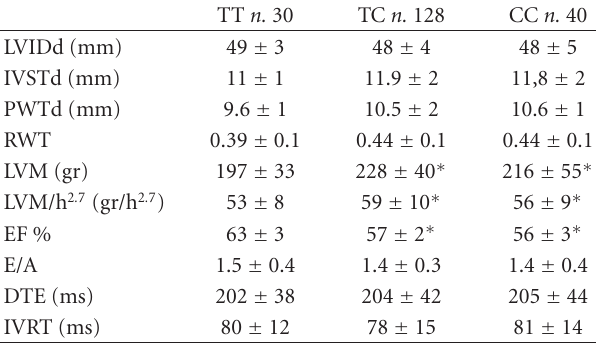
Table 4: Left ventricular geometry and function in hypertensives with left ventricular hypertrophy subgrouped according to Leu 10 → Pro 10 TGF β 1